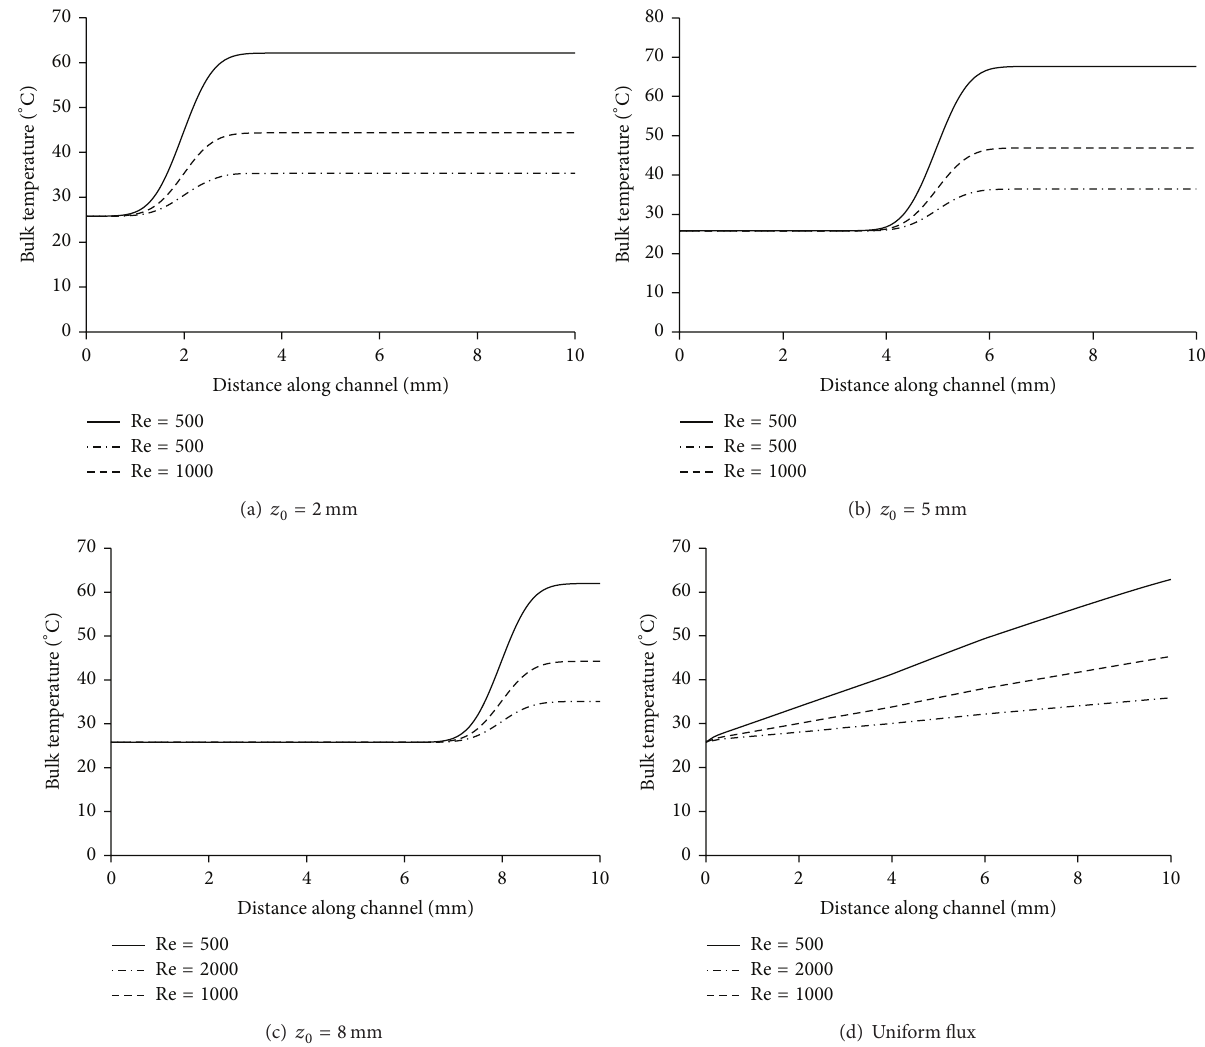
Figure 11: Variations in fluid bulk temperature obtained using different values of Re, when SD = 0.001, 𝜀 = 0.95 , and 𝐶 = 100 .